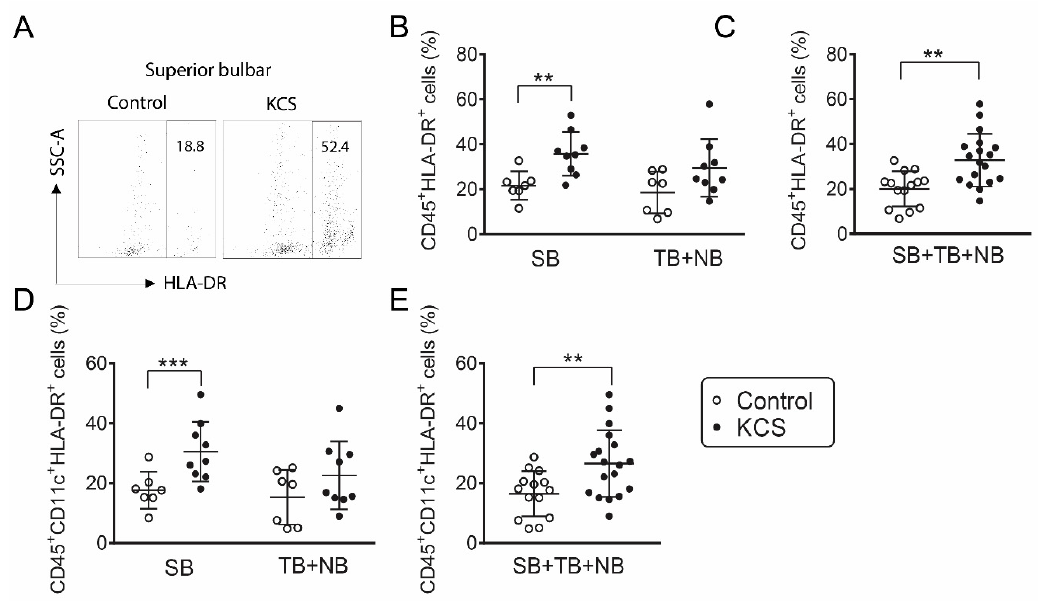
Figure 3. Increased percentage of HLA-DR + cells in KCS patients. ( A ) Representative dot plots of flow cytometry showing HLA-DR + cells gated from live CD45 + population in the control and KCS samples. ( B ) Accumulative data showing percentage of CD45 + HLA-DR + cells in the superior bulbar (SB) and nasal bulbar (NB) + temporal bulbar (TB) conjunctiva in the control ( n = 7) and Sjögren’s syndrome (SS) subjects ( n = 9) and ( C ) the corresponding accumulative data for all three bulbar conjunctival sites. ( D ) Accumulative data showing percentage of CD45 + CD11c + HLA-DR + cells in SB and NB + TB conjunctiva in the control ( n = 7) and SS subjects ( n = 9) and ( E ) the corresponding accumulative data for all three bulbar conjunctival sites. Data shown as scatter plots with mean ± SD. ** p < 0.01; *** p < 0.001, Mann–Whitney test.